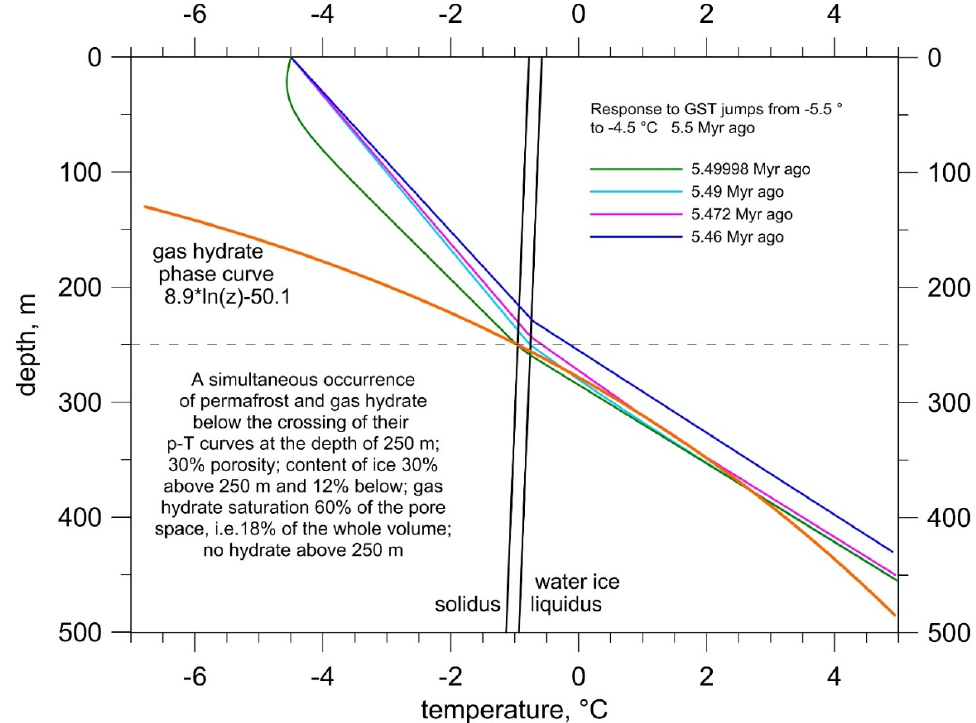
Figure 4. Transient temperature–depth profiles as a response to the sudden GST warming from − 5.5 °C to − 4.5 °C, 5.5 Mya (and to all previous GST changes since 14 Mya). The profiles correspond to times 20, 10 ka, 28 ka and 40 ka after the warming began. Curves for 28 ka illustrate the moment when the last GH dissipates in the depth interval 310–340 m, separated from the permafrost base at the depth of 240 m by a 70 m thick melted